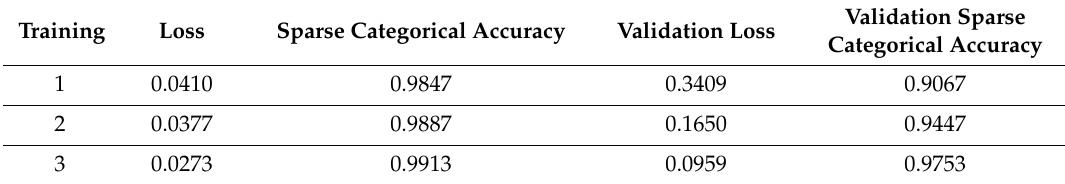
Table 1. Training results.